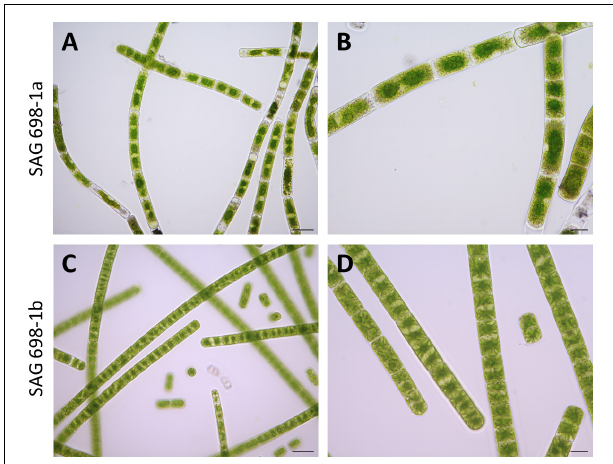
FIGURE 1 | Microscopic images of SAG 698-1a and SAG 698-1b. The algae consist of cylindrical, non-branching filaments cells. Each cell contains two stellate chloroplasts, between which exists one nucleus. Images were taken with an Axio Imager 2 microscope (Carl Zeiss Microscopy, LLC). (A,B) SAG 698-1a; (C,D) SAG 698-1b. Scale bars: 50 µ m (A,C) and 20 µ m (B,D) .